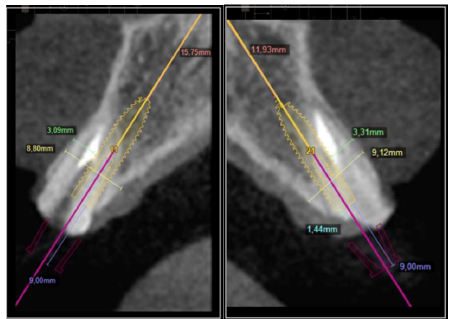
Figure 4. Planning the reconstruction of elements #11 and #21 in the DSD program.